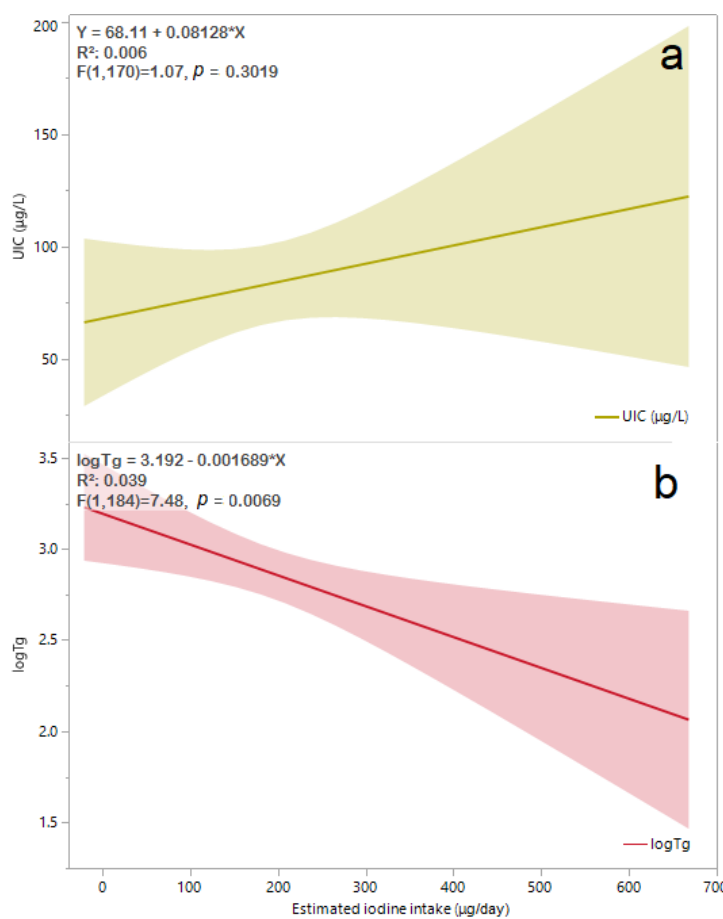
Figure 2. Available UIC ( a ) levels ( N = 165) and logTg ( b ) values ( N = 189) by estimated iodine intake obtained from sIFFQ. The regression line equation, R 2 and p value for associations of UIC and logTg are shown in the left ‐ upper area of ( a ) and ( b ), respectively. The solid line represents the estimated linear fit, and the shaded areas are the 95% CI. After adjusting for participants’ age, smoking status, and gravidity, the correlation between logTg and estimated iodine intake remained significant [ β (95% CI) = − 0.198 ( − 0.0005, − 0.003), p = 0.04]. Abbreviations: UIC, urinary iodine concentration; sIFFQ, semi ‐ quantitative iodine food frequency questionnaire; log Tg, serum log ‐ transformed thy ‐ roglobulin; CI, confidence interval. Table 2. Maternal iodine status and thyroid function tests a classified below and above EAR with the aid of sIFFQ for estimating iodine intake adequacy.